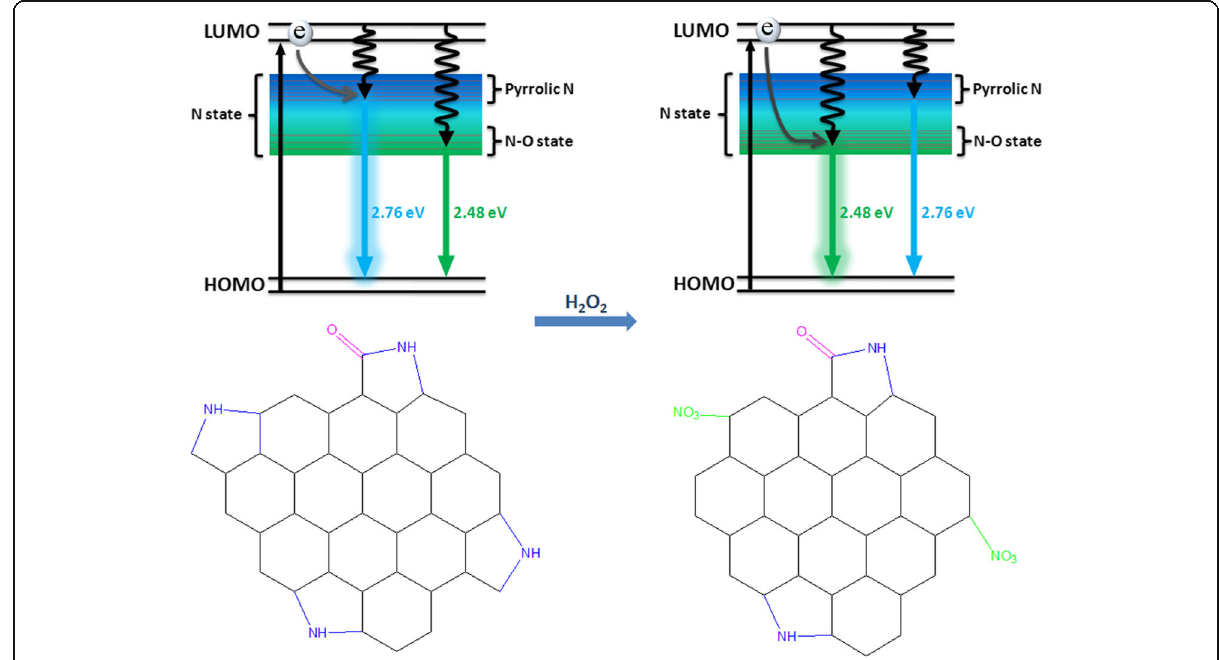
Fig. 3 The possible sensing mechanism for CDs before ( left ) and after ( right ) adding H 2 O